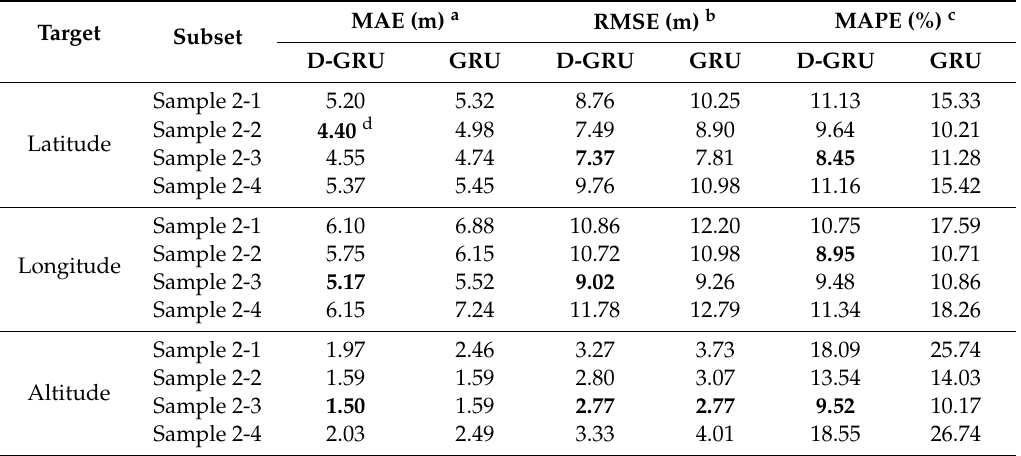
Table 3. Comparison of the prediction accuracy with di ff erent training samples for Mavic 2 quadrotors. Target